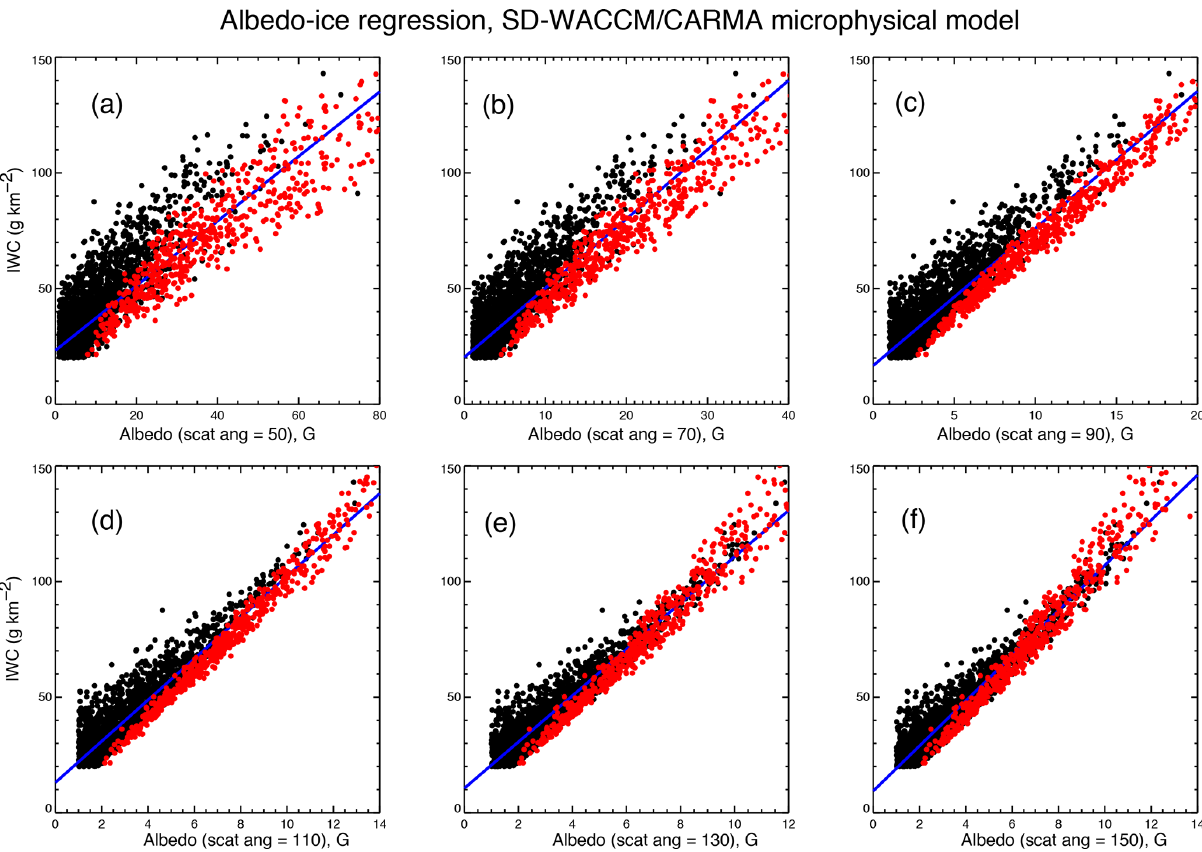
Figure 1. Linear regressions of model PMC albedo versus model PMC ice water content. The black points represent model clouds with r eff < 40nm. The red points apply to r eff > 40nm. The blue line is the linear least-squares fit to all points. Panels (a) through (f) are for different scattering angles. The lower limit for the albedo (SA = 90 ◦ ) is 1G, which is the detection limit of the CIPS